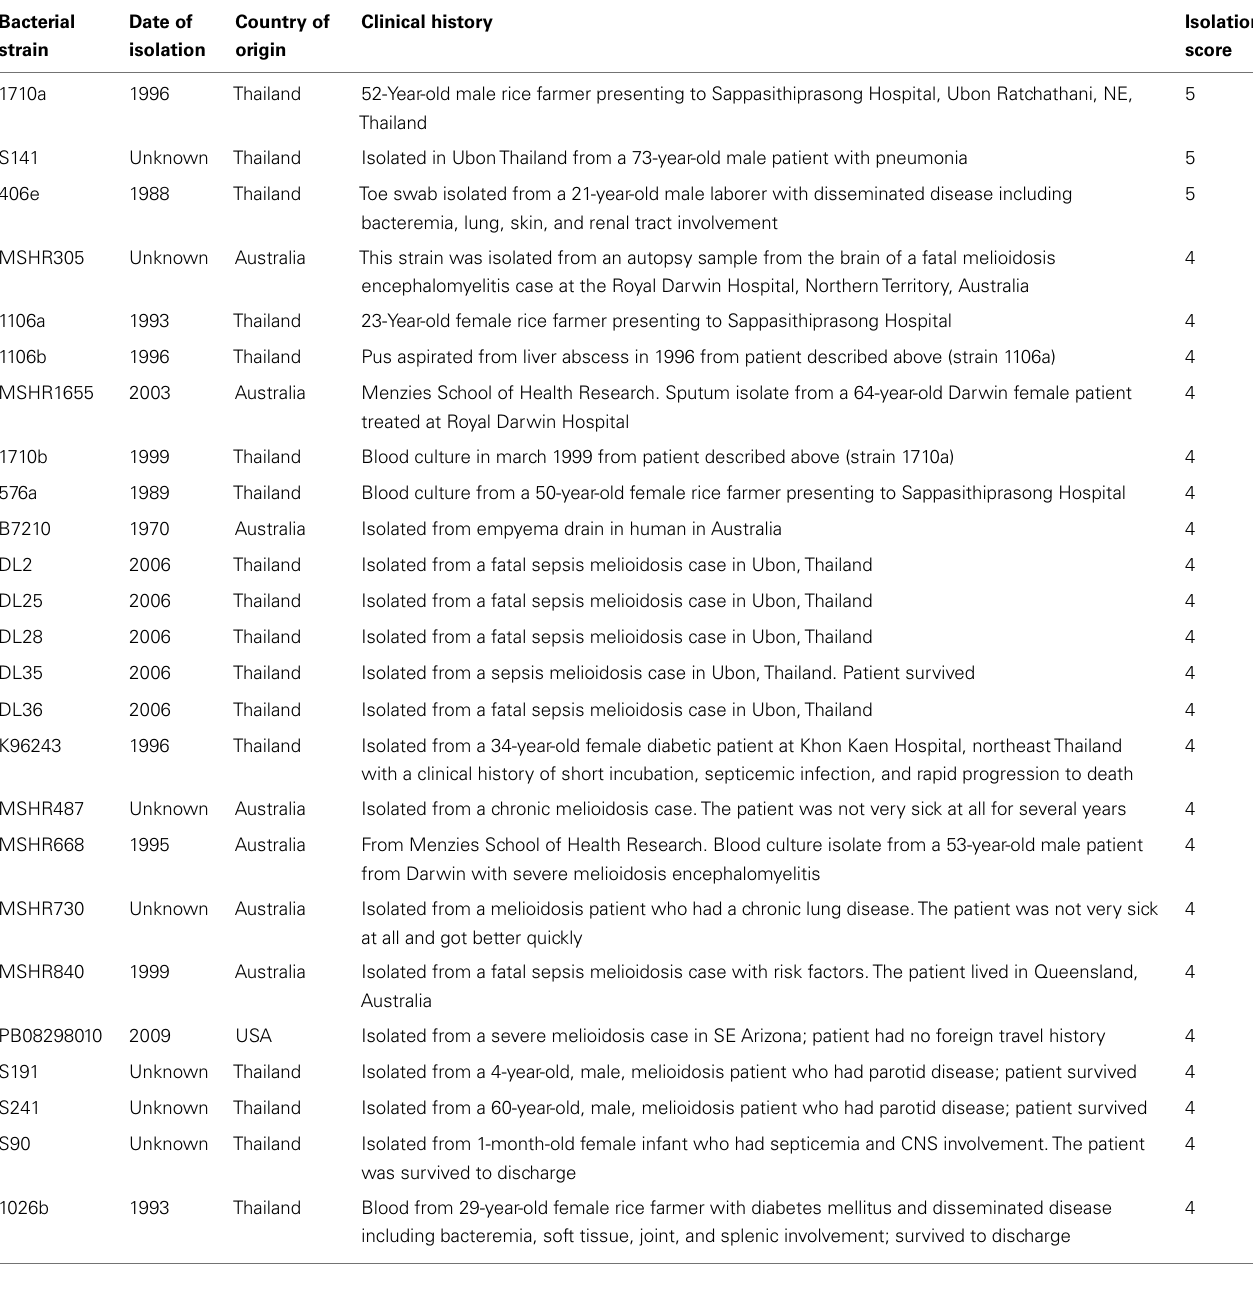
Table 1 | Burkholderia pseudomallei strains with well described clinical